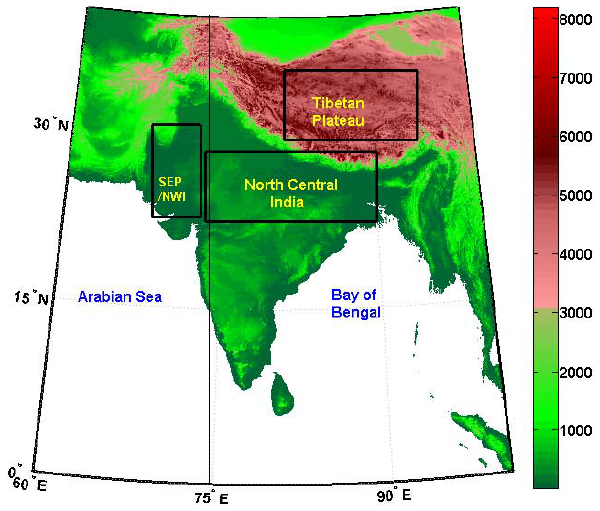
Fig. 1. The topography (color coded, in meters above sea level) of the sector analysed in this paper. The black line at 75E indicates the separation for spatial aggregation in the analysis of active and break periods of the monsoon. The boxes “Tibetan Plateau” and “North Central India” identify the regions mentioned in the text. The land and sea areas in this entire study area are considered later for the